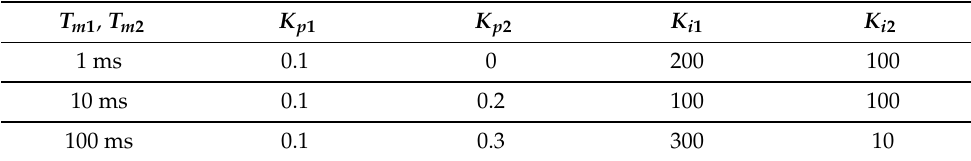
Figure 13. Eigenvalues for different measurement delays with proposed ( a ) SSDC-A ( b ) SSDC-B. Table 7. SVC control gains with SSDC-B considered in Section